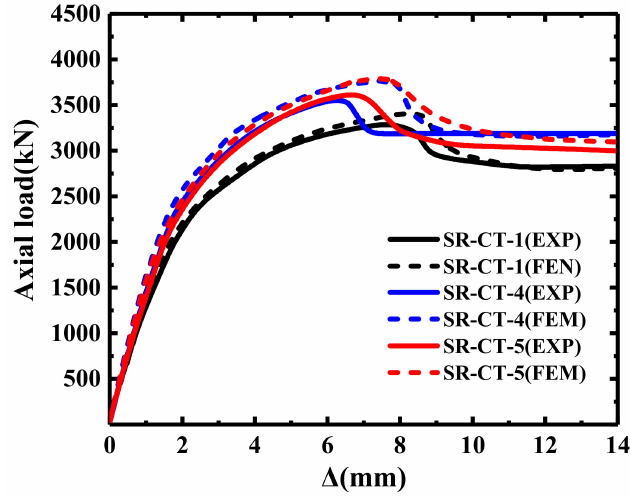
Figure 14. Load–displacement curves of members with different skeleton contents.